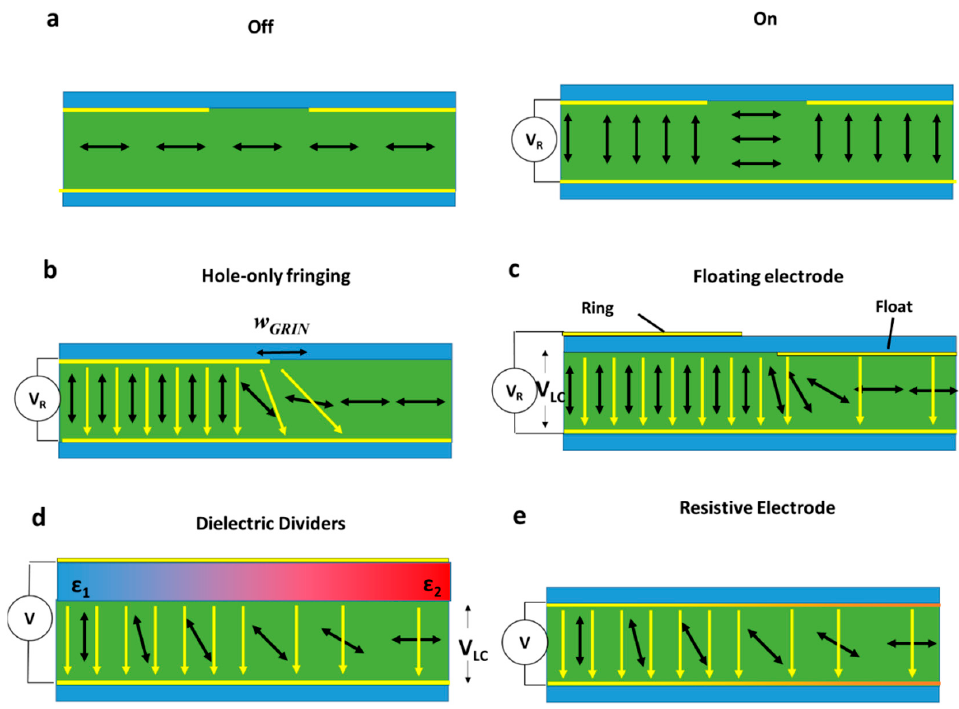
Figure 5. Methods of creating and improving GRIN devices with planar electrodes. ( a , b ) Shows a hole-patterned lens which is either on or off. ( c ) Shows a zoomed-in schematic, where the fringing field causes the director to reorient over a width w GRIN . ( c – e ) Show methods of increasing w GRIN through additional device features. ( c ) Shows an additional “floating” electrode. ( d ) Shows this combined with a variation in the permittivity of the substrates, smoothly reducing the applied field. ( e ) Shows the effect of resistive electrodes, where yellow electrodes indicate full charging, while orange represents no